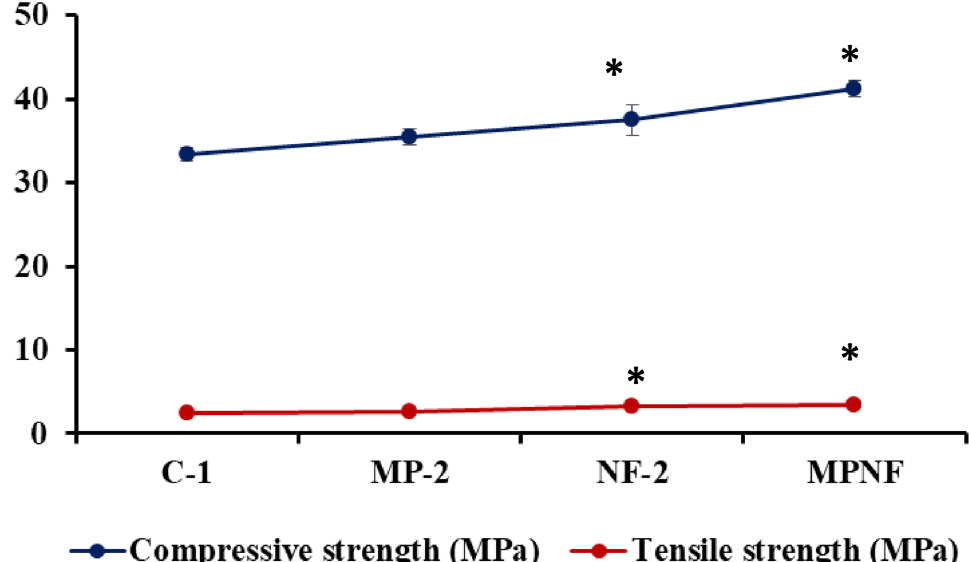
Fig. 5 ANOVA results; the significance of control and experimental results with different replacements (* Indicates significance at p < 0.05 when compared between NF-2 and MPNF vs other mix design